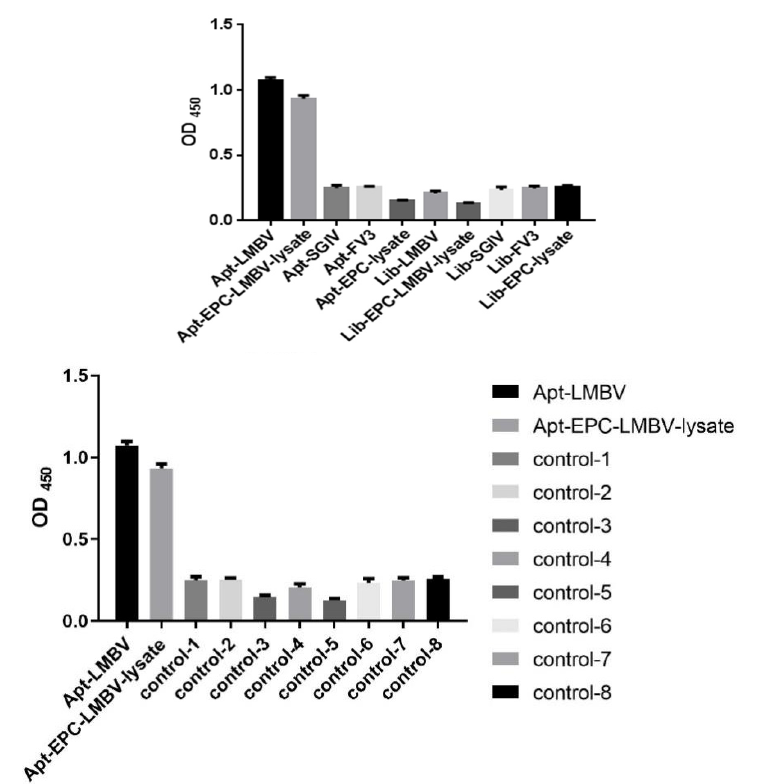
Figure 3. Specificity of the sandwich ELASA. The names along the X -axis are illustrated in detail as follows: Apt-LMBV indicates LA38s-LMBV-LA13s sandwich model. Apt-EPC-LMBV-lysate indicates LA38s-the lysates of LMBV-infected EPC-LA13s sandwich model. Apt-SGIV indicates LA38s- SGIV-LA13s sandwich model. Apt-FV3 indicates LA38s-FV3-LA13s sandwich model. Apt-EPC-ly- sate indicates LA38s-EPC-LA13s sandwich model. Lib-LMBV indicates Library-LMBV-Library sandwich model. Lib-EPC-LMBV-lysate indicates Library-the lysates of LMBV-infected EPC. Lib- SGIV indicates Library-SGIV-Library sandwich model. Lib-FV3 indicates Library-FV3-Library sandwich model. Lib-EPC-lysate indicates Library-EPC-Library sandwich model. SGIV, FV3, EPC and Library were used as control. 3.3. Optimum Working Concentration of Aptamers Used in the Sandwich ELASA Various concentrations of LA13s (0, 25, 50, 100, 200, 250, 500 and 1000 nM) were used to construct the sandwich ELASA. As shown in Figure 4, the sandwich ELASA dose-de- pendently detected LMBV. The effective detection was observed when the aptamer con- centration was as low as 200 nM. When the aptamer was less than 200 nm, the OD 450 was significantly decreased. However, the OD 450 in the control group (SGIV used as control target) showed no obvious binding at different concentrations of aptamer. Therefore, it is inferred that the optimal aptamer working concentration for the sandwich ELASA is 200 nM.